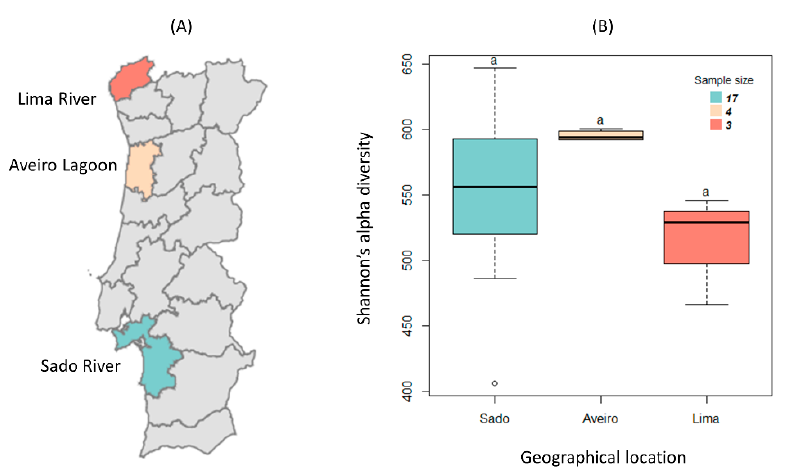
Figure 1. Distribution of Shannon’s alpha diversity of each metagenome by geographic location of the river or estuary from which they originate: Sado, Aveiro, and Lima. ( A ) Geographical regions under study shown on a map of Portugal. ( B ) Each boxplot represents a geographical location, namely the Sado River (blue), Aveiro Lagoon (beige), and Lima River (salmon). The sample sizes are 17, 4, and 3, respectively. The bottom and top of the boxplot represent the first and third quartiles, the horizontal line is the median, and the vertical dashed lines are the 1.5 interquartile range. The black circles represent the outliers. Kruskal–Wallis’s analysis indicated that there are no significant differences in Shannon’s alpha diversity between the three geographical locations, as indicated by the letter a ( p -value > 0.05).